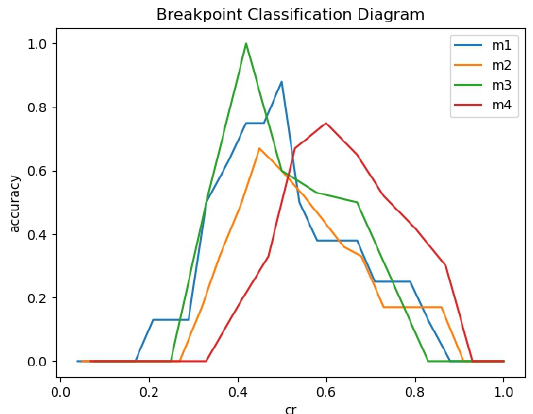
Figure 3. Breakpoints Classification